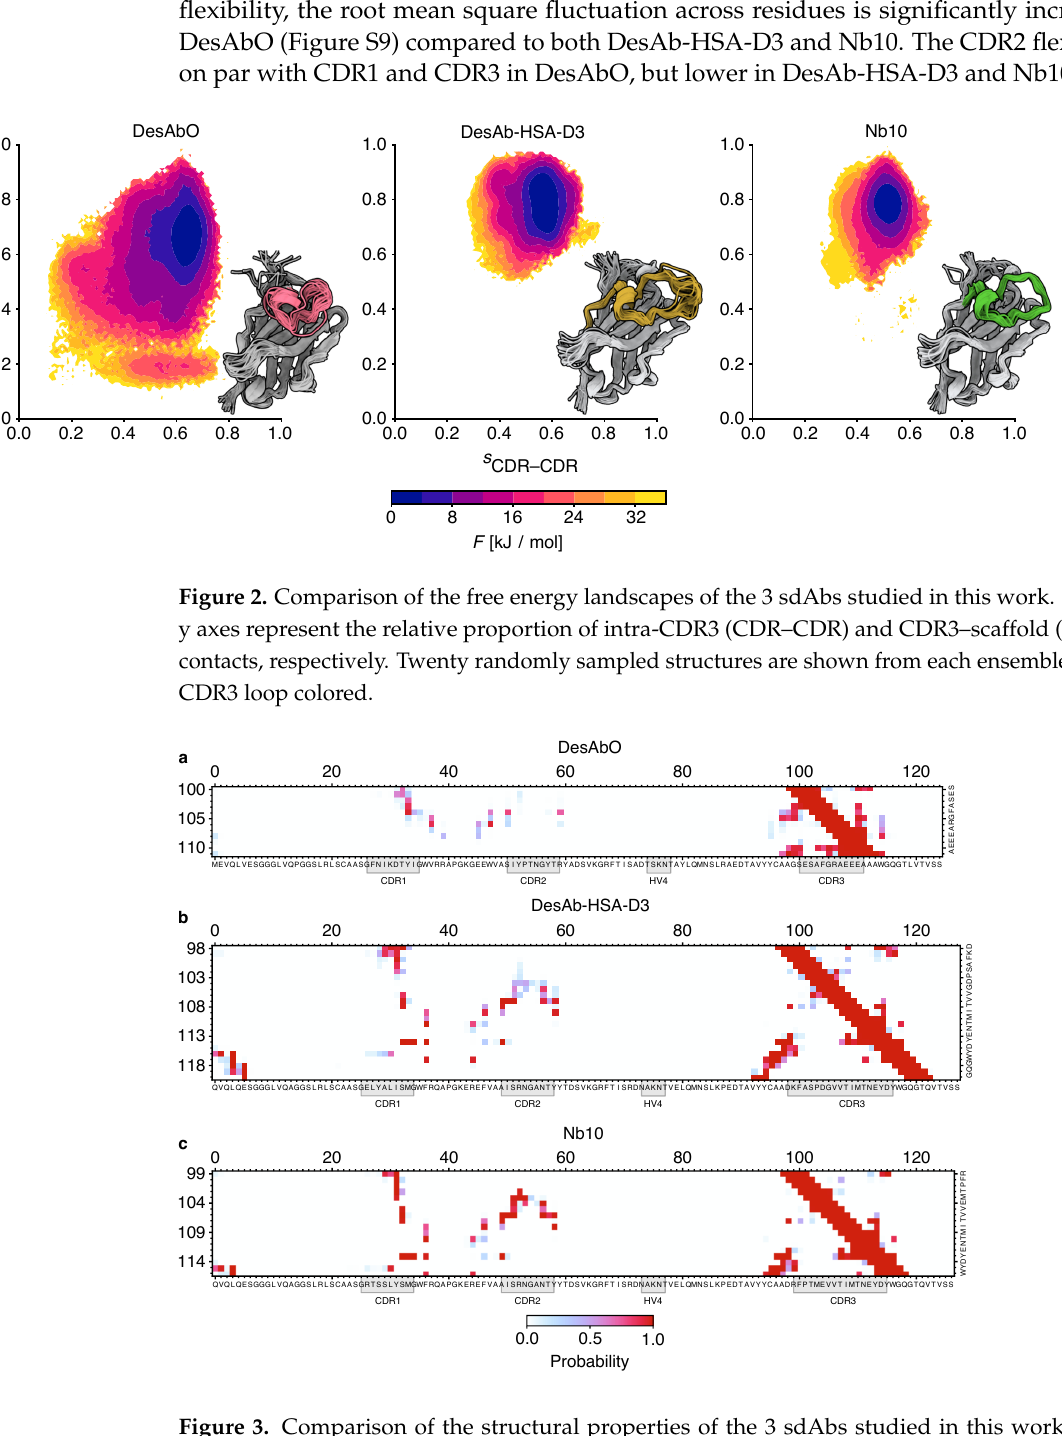
Figure 3. Comparison of the structural properties of the 3 sdAbs studied in this work. Contact maps for DesAbO ( a ), DesAb-HSA-D3 ( b ) and Nb10 ( c ) for CDR–scaffold contacts, indicating the probability of forming a contact between two